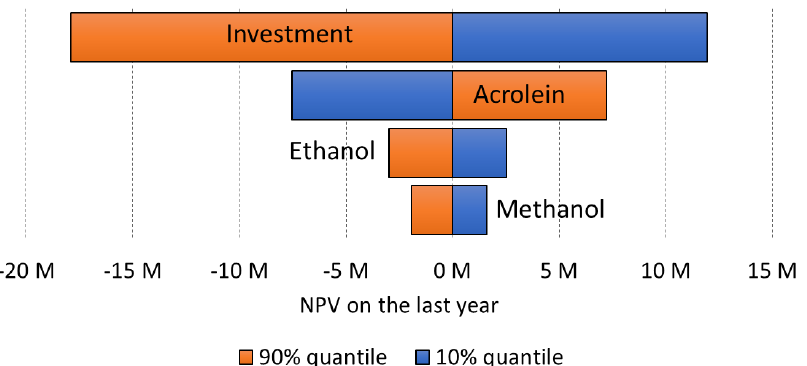
Figure 20. Tornado plot for a small plant (10,000 tons/year) at 70% yield, without subsidies. For the capital cost, we used a − 20/+ 30% distribution on the median CAPEX corresponding to probability range of P24 and P68, respectively, and a Class 3 confidence.